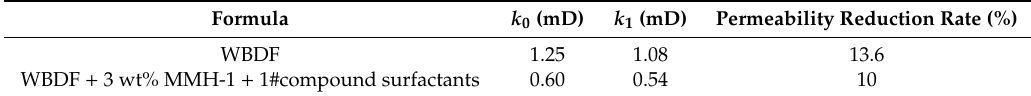
Table 9. E ff ect of drilling fluid on coal sample’s permeability.